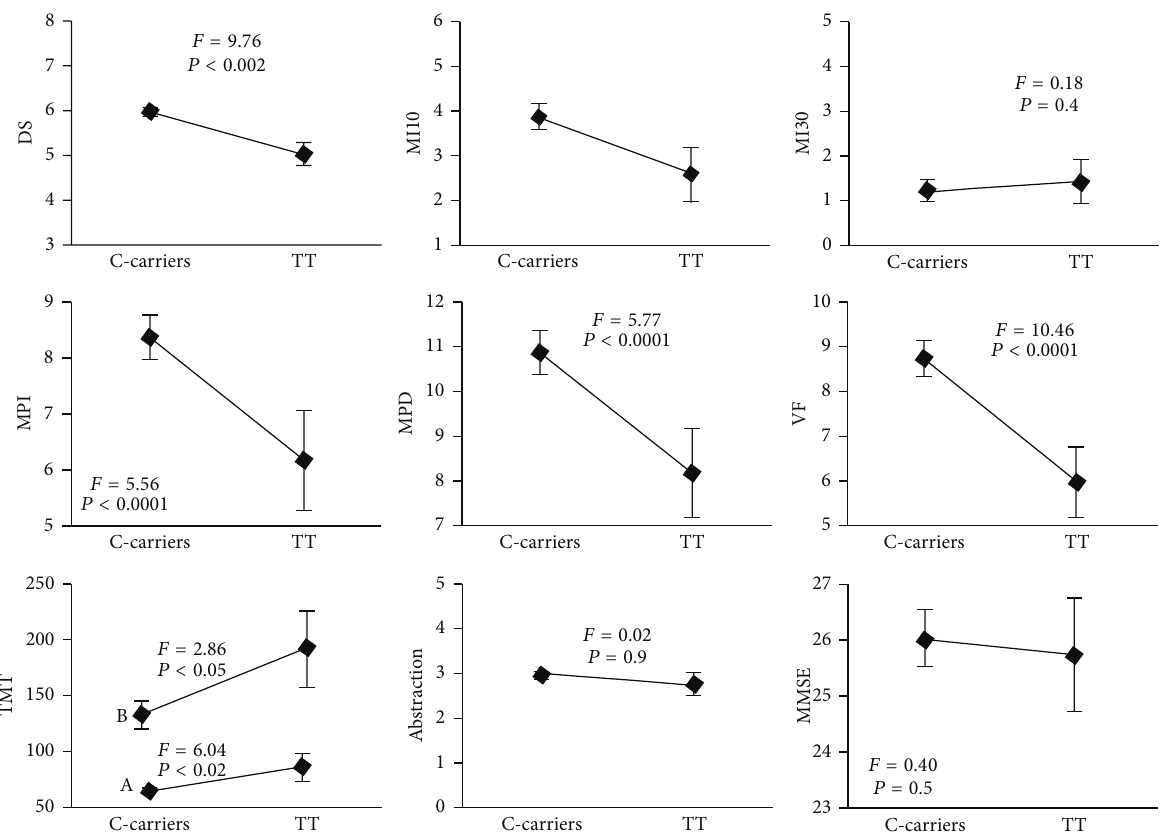
Figure 1: Scores of the neuropsychological tests in relation to C825T polymorphism of GNB3 gene in 220 subjects from general population. MI: memory with interference at 10 and 30 seconds, IPM and DPM: immediate and delayed prose memory, VF: verbal fluency, TMTs: trail making tests A and B, MMSE: mini-mental state examination.